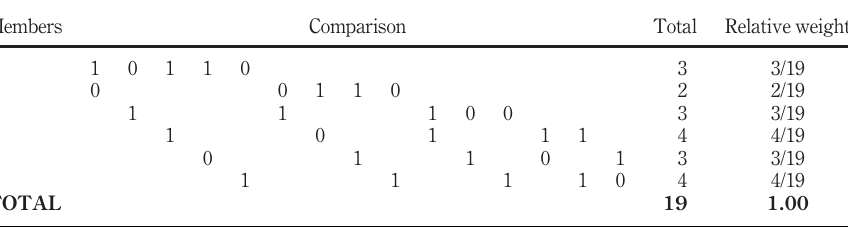
2. Competence: Table 2 Paired comparison chart of each member on ‘ Competence ’